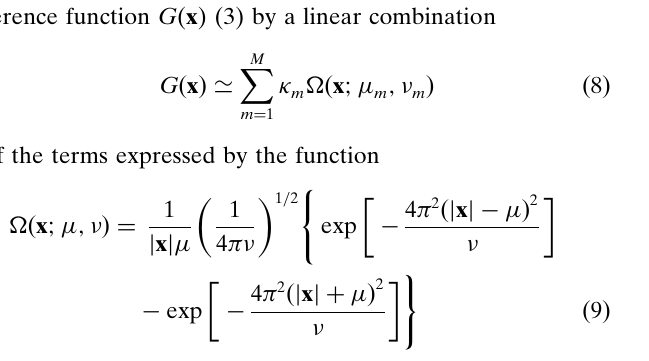
ð Þ . Each ;(cid:6) (cid:2) x ; (cid:5) 2 2 2